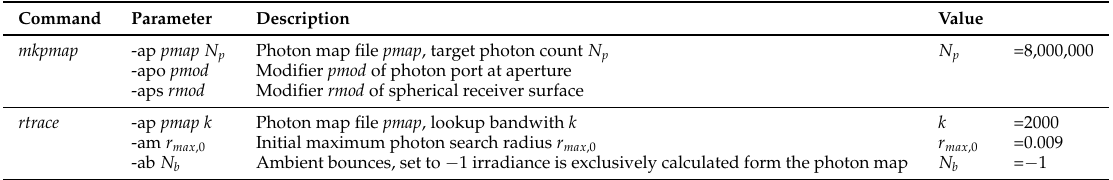
Table 1. Simulation parameters applied in the implementation of a Virtual Goniophotometer in Radiance.